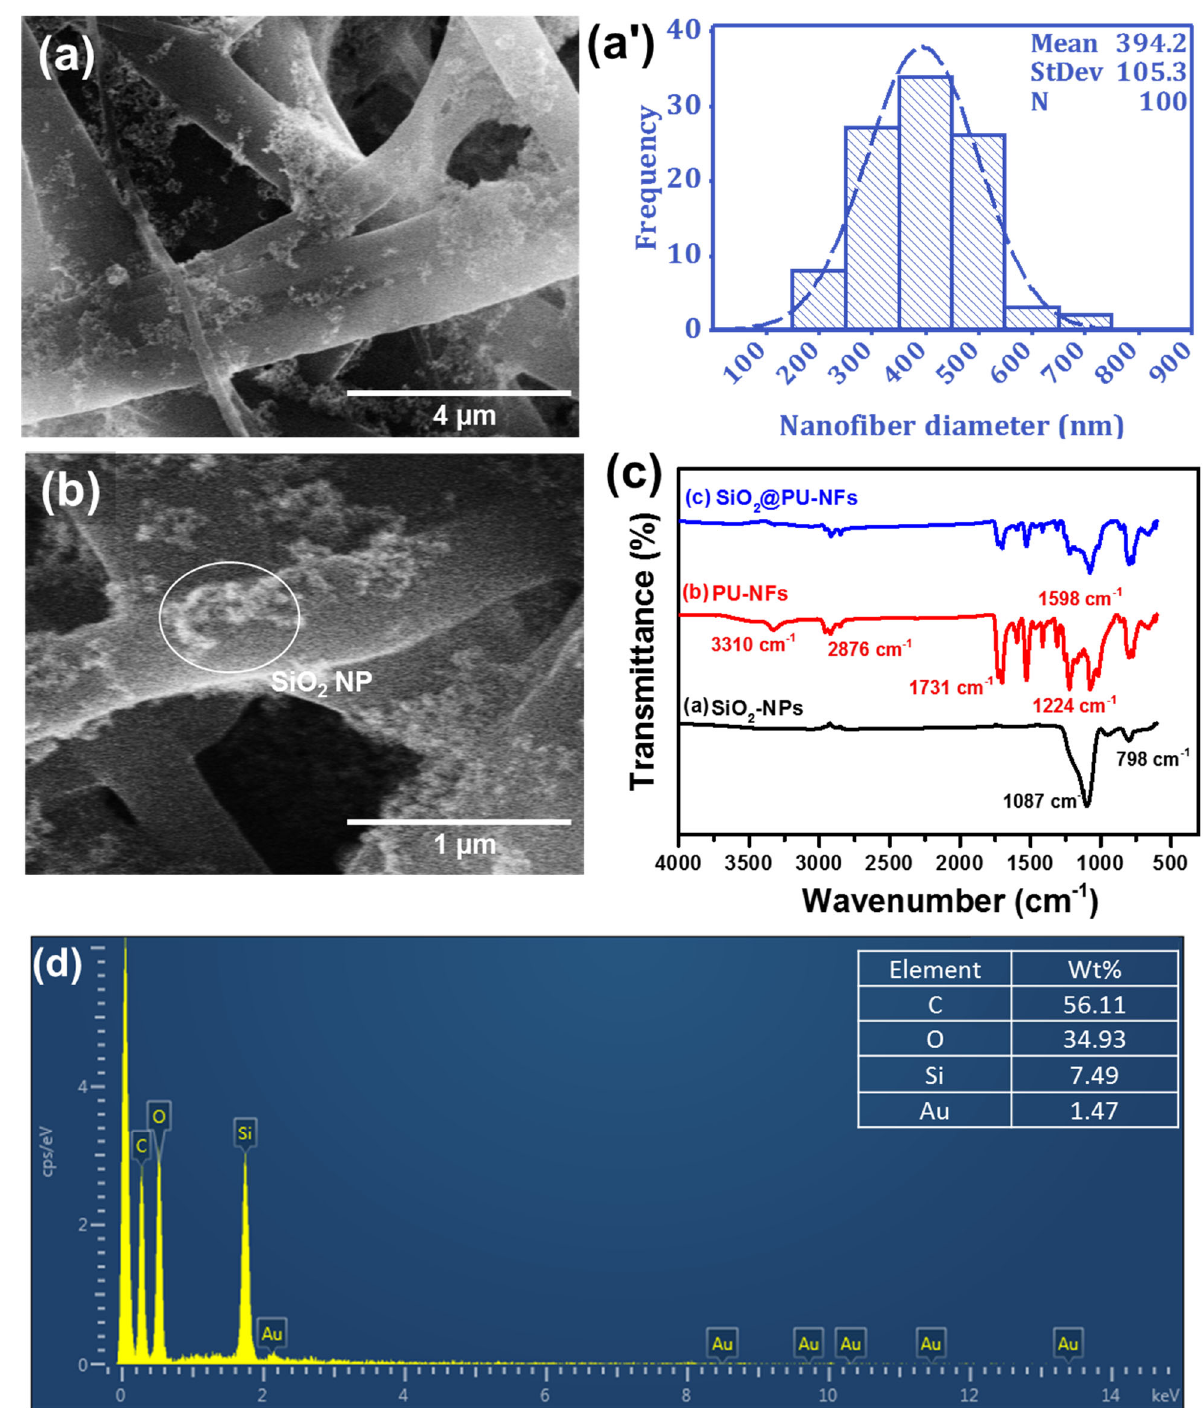
Figure 4. ( a , b ) SEM images of f composite SiO 2 @PU − NFs membrane containing SiO 2 -NPs; ( a ′ ) high- resolution SEM images of composite membrane, revealing the presence of SiO 2 -NPs; ( c ) FTIR spectra of SiO 2 -NPs, PU-NFs, and SiO 2 @PU-NFs; ( d ) elemental analysis of the composite nano fi brous mem- brane.